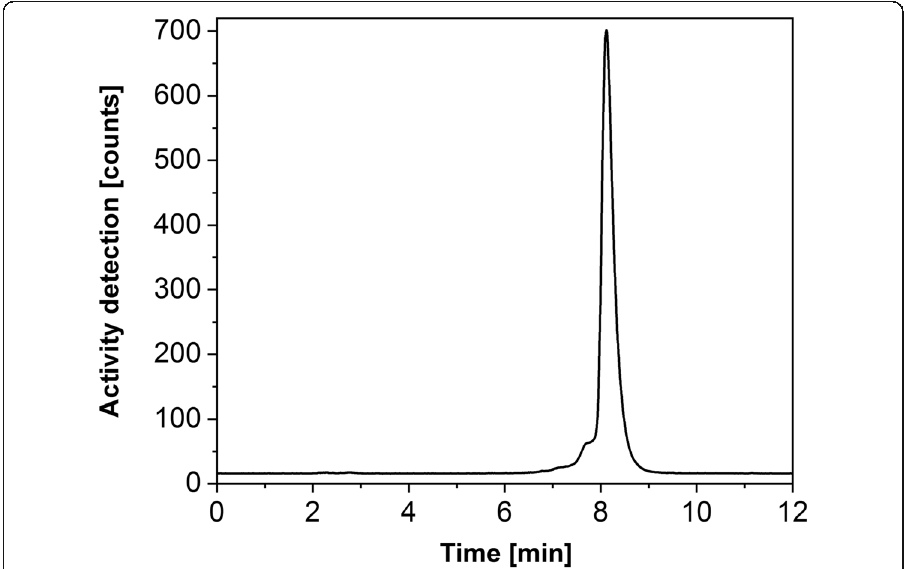
Fig. 4 HPLC chromatogram of 161 Tb-DOTANOC (2.3 min retention time would indicate “ free ” or unlabeled 161 Tb, while 8.2 min indicates 161